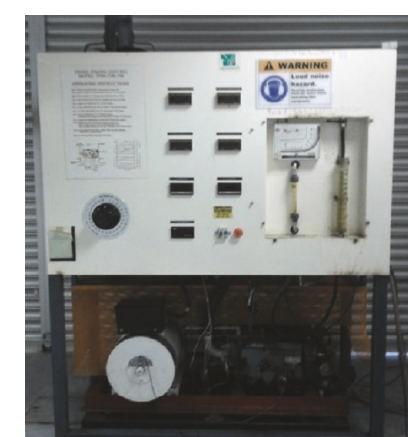
Figure 3: Diesel Engine Performance Test Bed (Techno-mate, TNM-TDE-700).